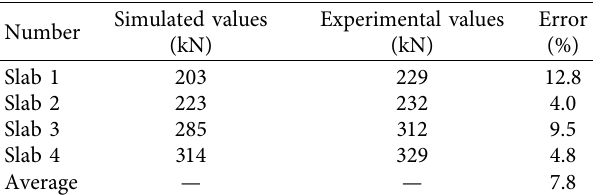
Figure 13: Comparison between simulated and experimental values: (a) Slab 1; (b) Slab 2; (c) Slab 3; (d) Slab 4. Table 6: Comparison between simulated and experimental values of ultimate load.